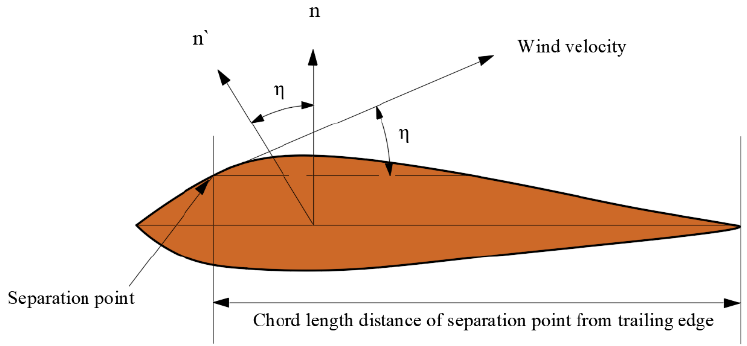
Figure 8. Diagram of high wind speed blade trailing edge flow separation.